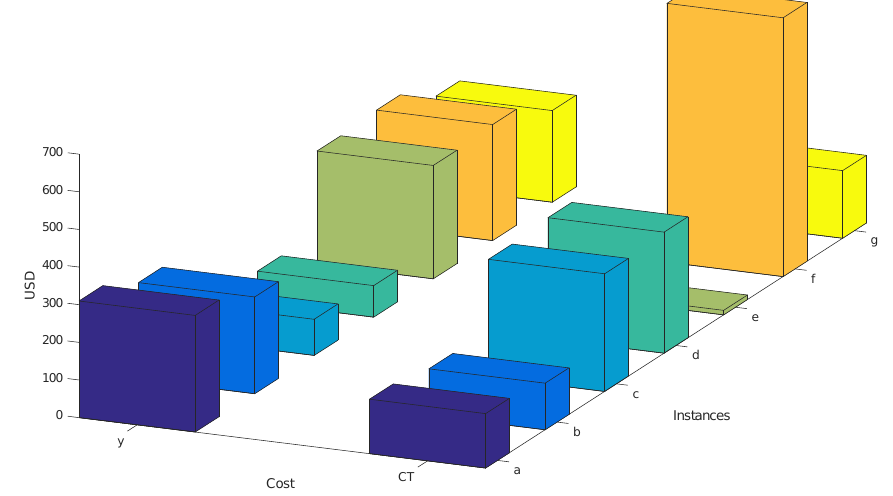
Figure 5. Behavior of costs in the cases analyzed.